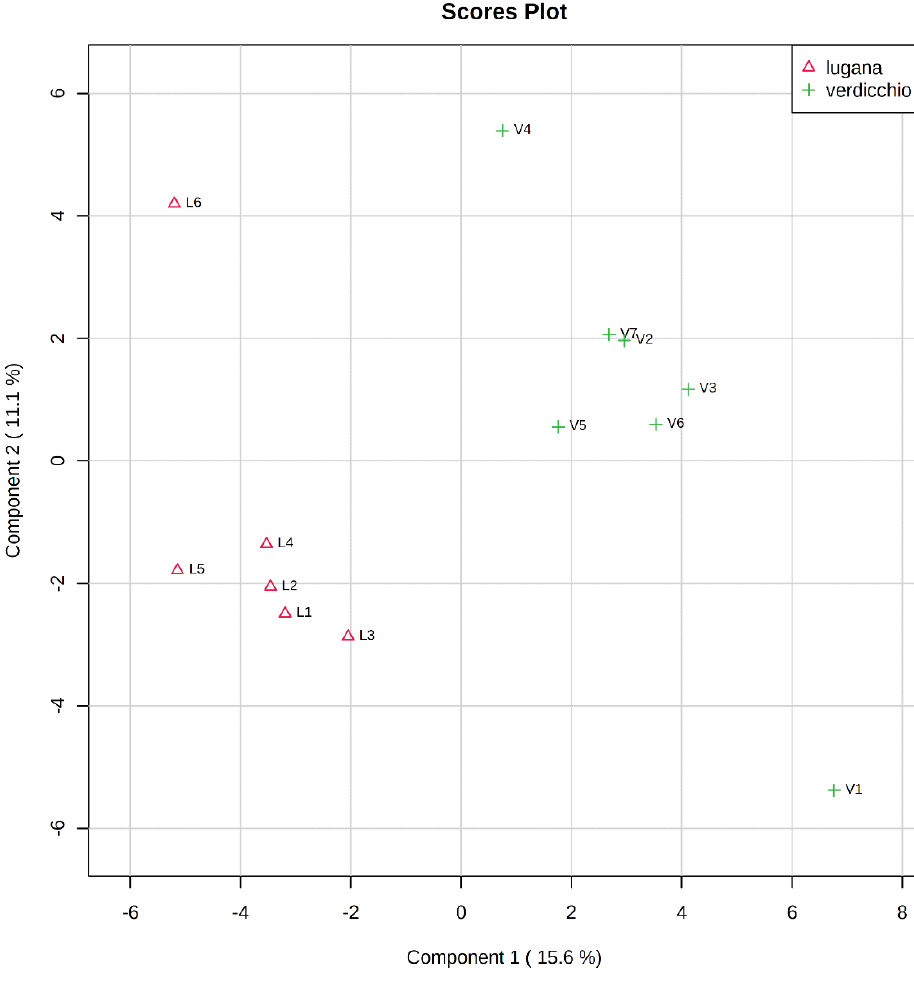
Figure 1. Partial least squares discriminant analysis (PLS-DA) scatterplot of Lugana and Verdicchio wines samples.